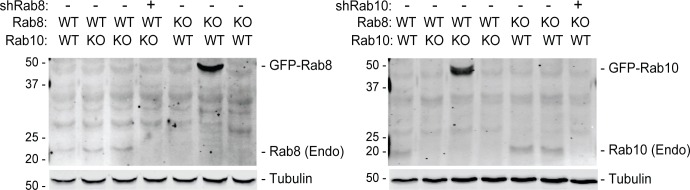
Documentation of Rab8A and Rab10 shRNA efficacy.A549 Rab10-KO and Rab8A-KO cells infected with lentivirus to deliver shRNAs targeting Rab8A or Rab10, respectively. A549 knock out cells were rescued by lentiviral delivery of GFP-Rab8A or Rab10. Immunoblot of 60 µg cell lysate probed with anti-GFP, anti-Rab8A or anti-Rab10 antibodies; tubulin was used as loading control. Numbers at left indicate mobility of molecular weight markers in kDa.